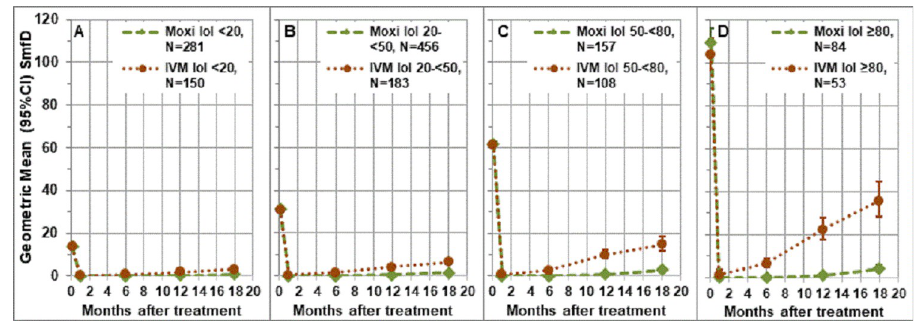
Fig 2. Geometric mean (95% CI) SmfD by intensity of infection category across study areas. SmfD skin microfilariae density, moxi moxidectin, IVM ivermectin, N number treated (for number with follow up data at each time point, see Table S4 in S 1 File